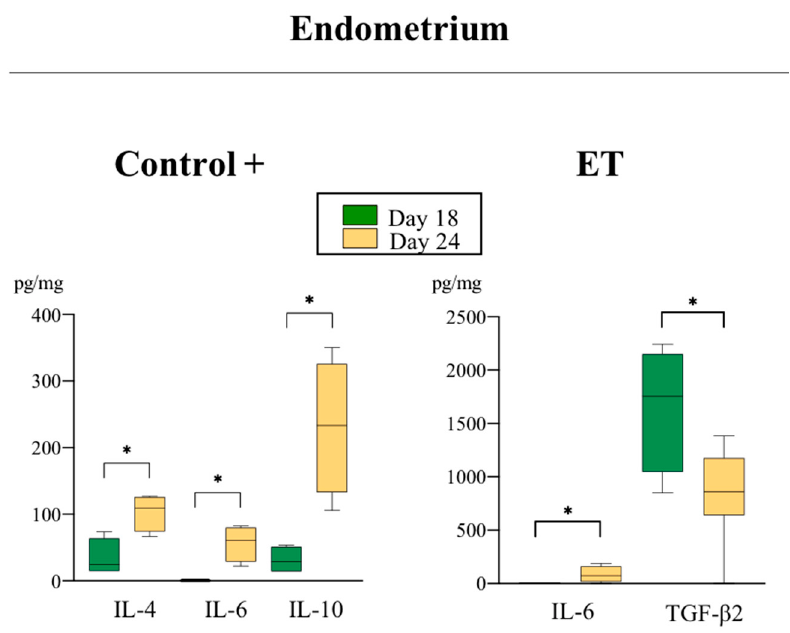
Figure 6. Relative abundance of anti-inflammatory cytokines (pg/mL) with different expression levels in endometrial samples (C+ and ET groups) in both periods of evaluation. Data are presented by box plot showing median and interquartile range (Q1–Q3). Asterisks indicate significant differences among groups (* p < 0.05; ** p < 0.01).